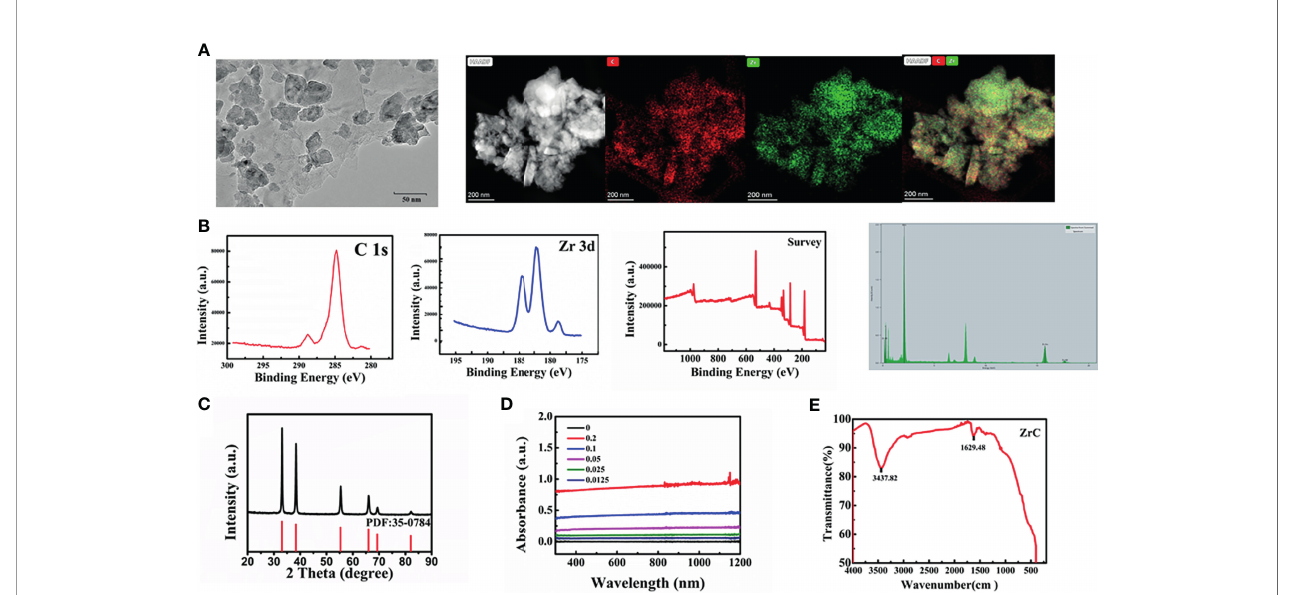
FIGURE 1 | (A) The TEM image and elements mappings image, (B) XPS, (C) XRD PDF:35-0784, (D) UV spectra: optical absorbance of ZrC dispersions with varied concentration, (E) the FTIR